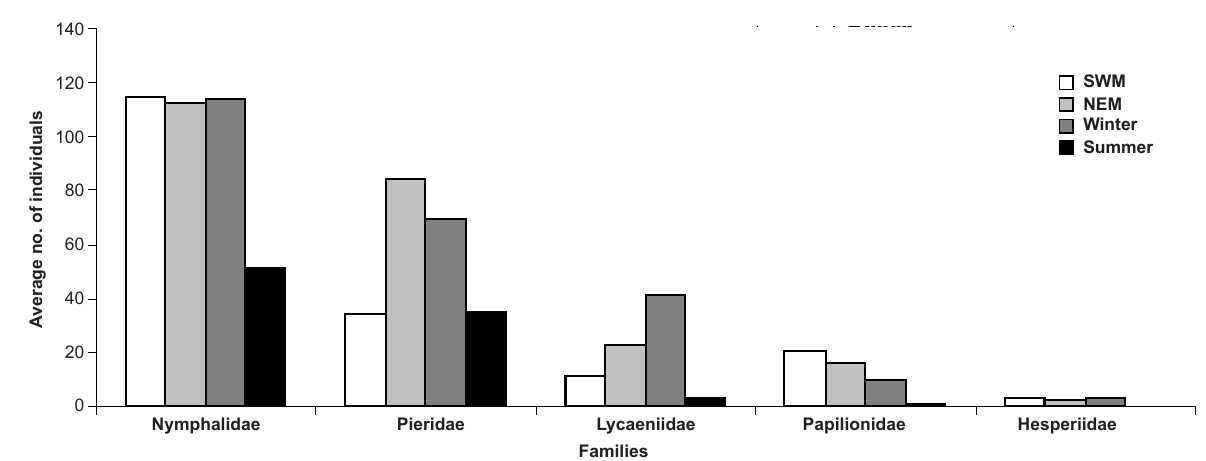
Figure 3. Population trends of butterfly families in different